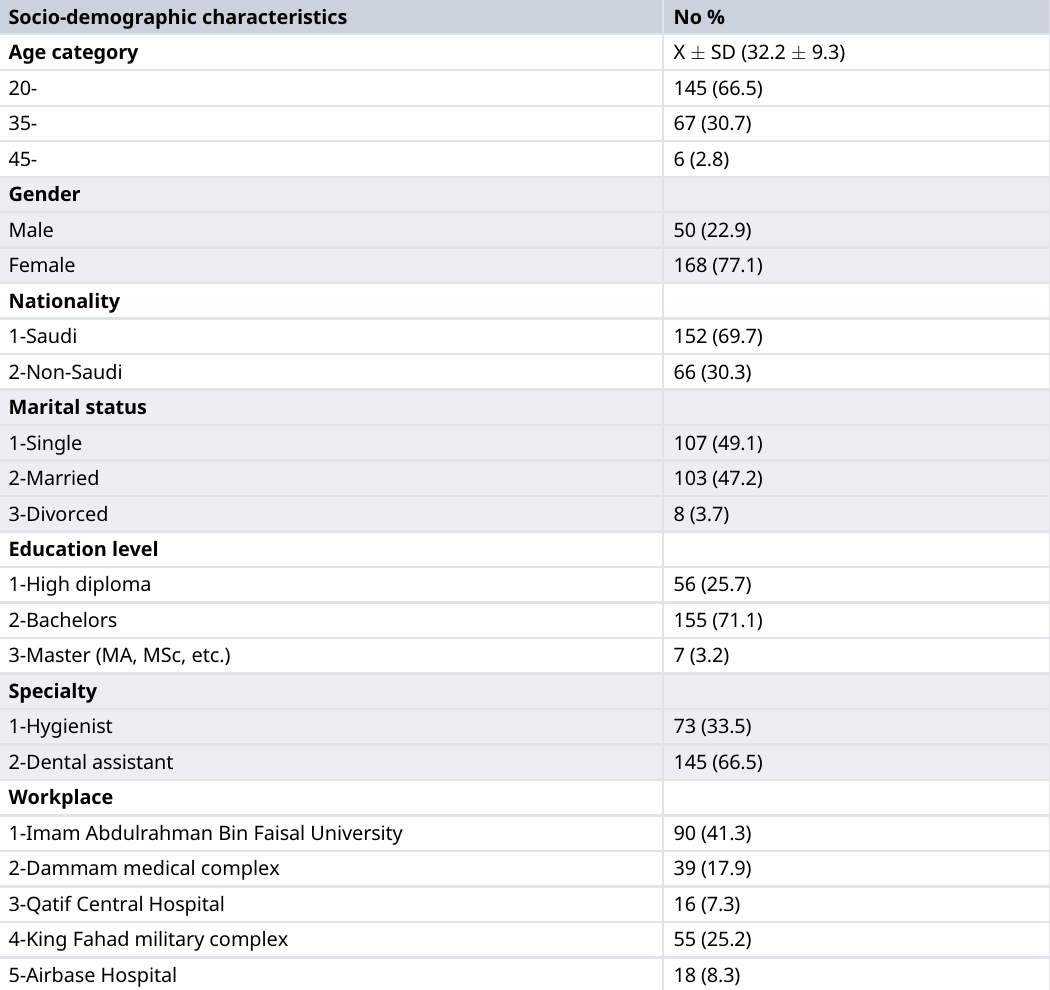
Table 1. Distribution of study participants according to socio-demographic characteristics